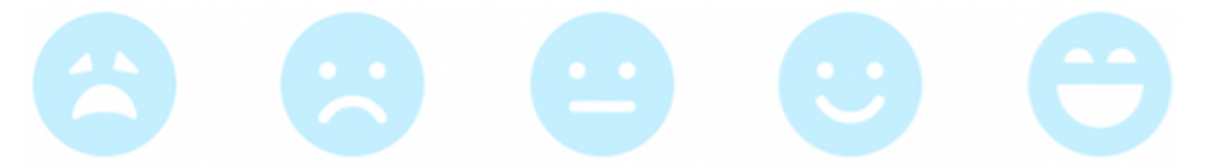
Figure 1. Smiley face-based rating system used in the BRISA app.